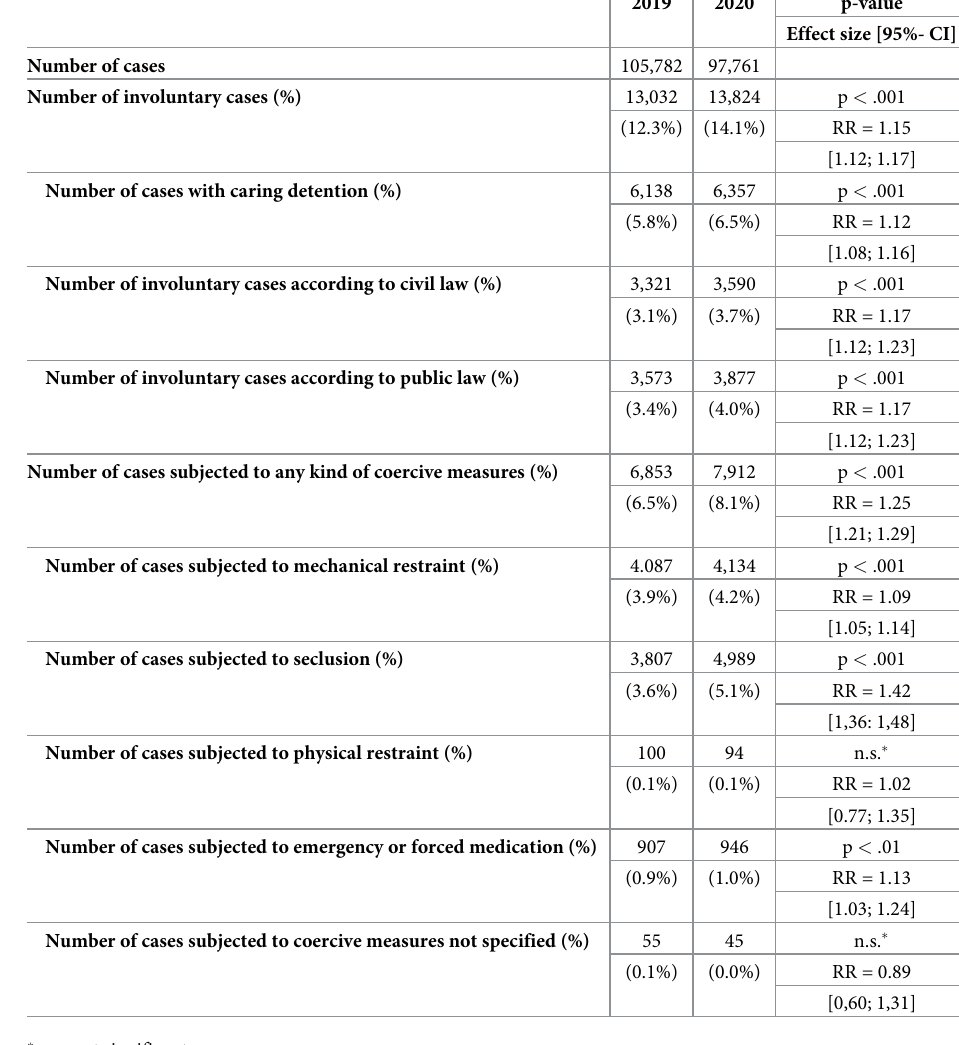
Table 1. Cases and percentages exposed to coercive interventions in 2020 compared to